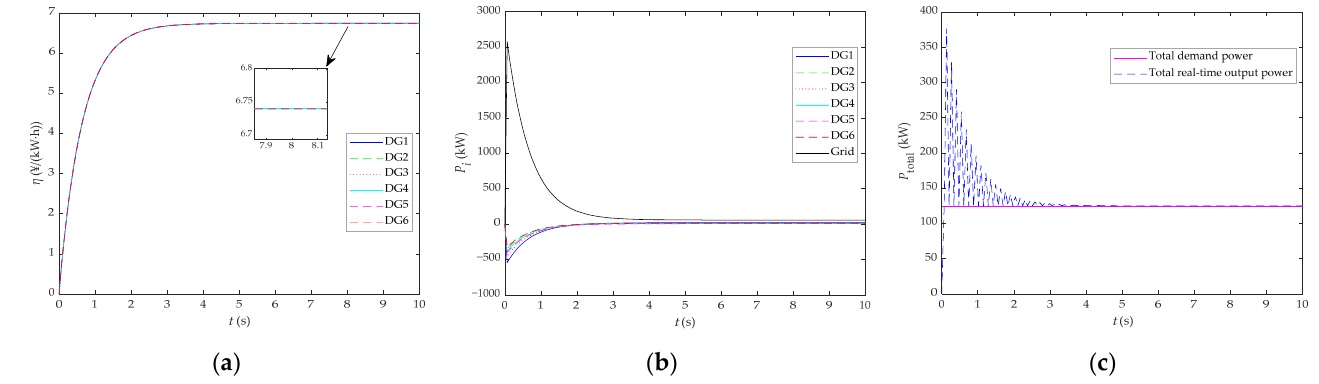
Figure 28. The change curves of variables of the system when both the initial ICR as well as initial active output are set at zero: ( a ) change curves of each DG’s ICR; ( b ) change curves of each DG’s active output and grid output power; ( c ) change curves of the cumulative sum of each DG’s active output and grid output power as well as total demand power.